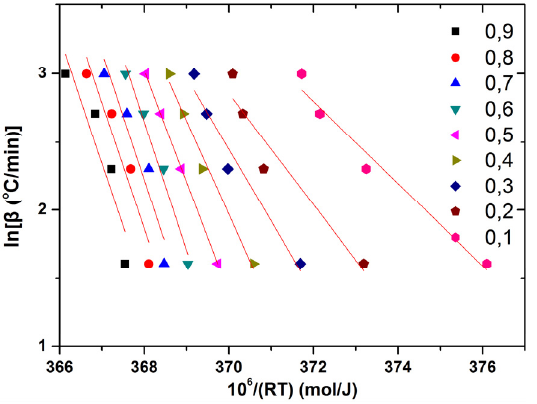
Figure 7. Typical plots for the estimation of the effective activation energy at different relative conversion values.